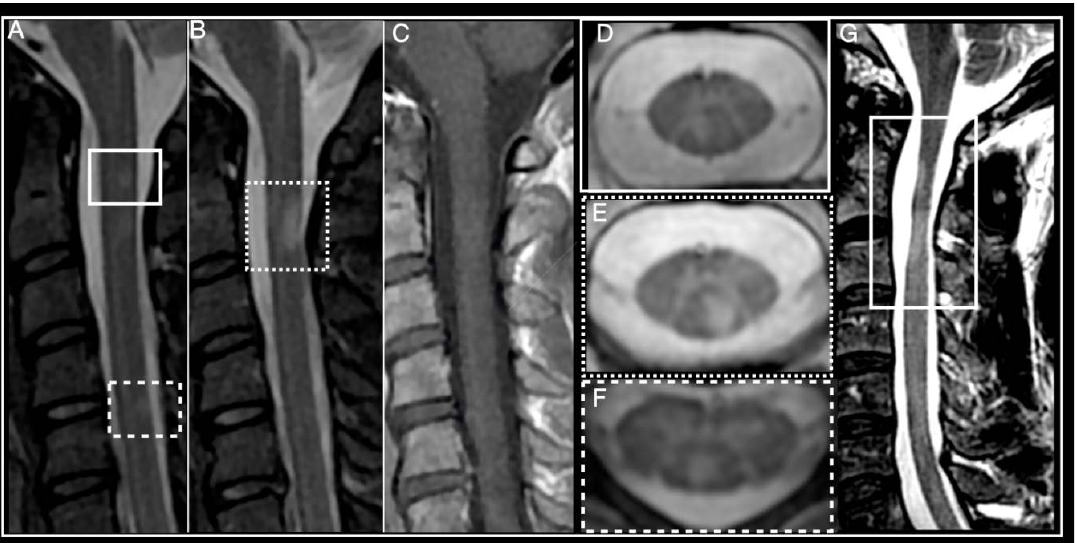
Figure 1. Multiple Sclerosis myelitis. ( A – F ) 32-year-old woman diagnosed with relapsing remitting